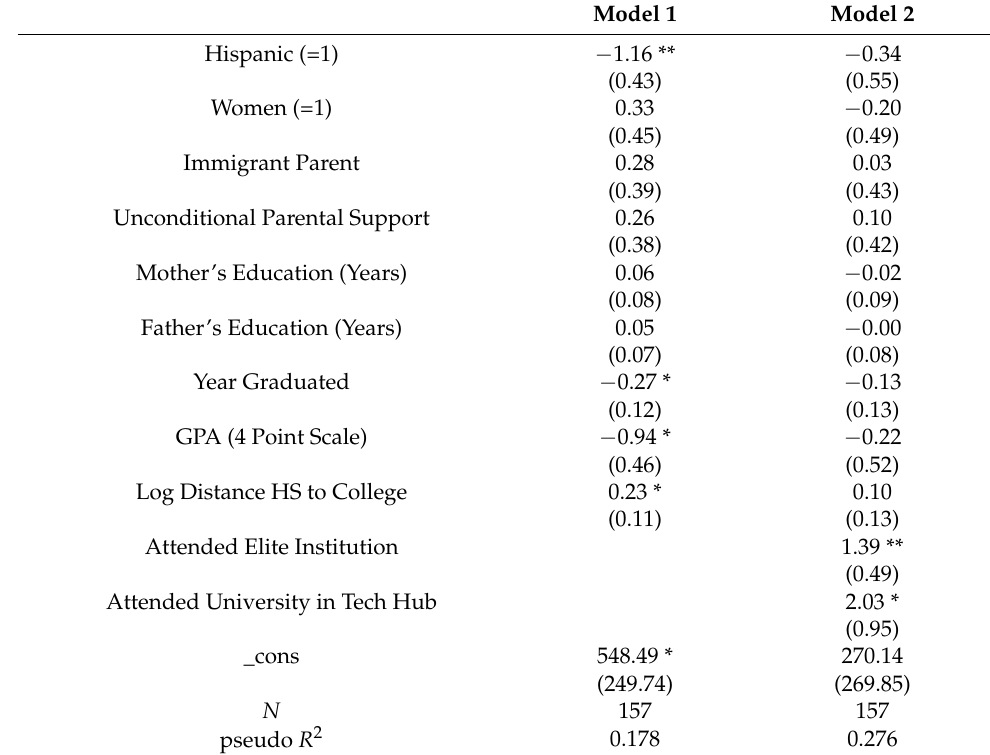
Table 3. Predictors of working in a prestige tech hub among recent CS degree recipients in Texas, 2018. Model 1 Model